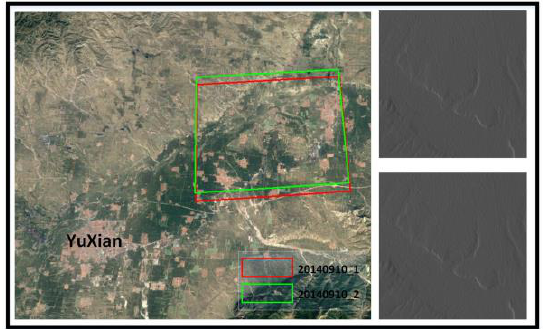
Figure 3. SRTM DEM of the study